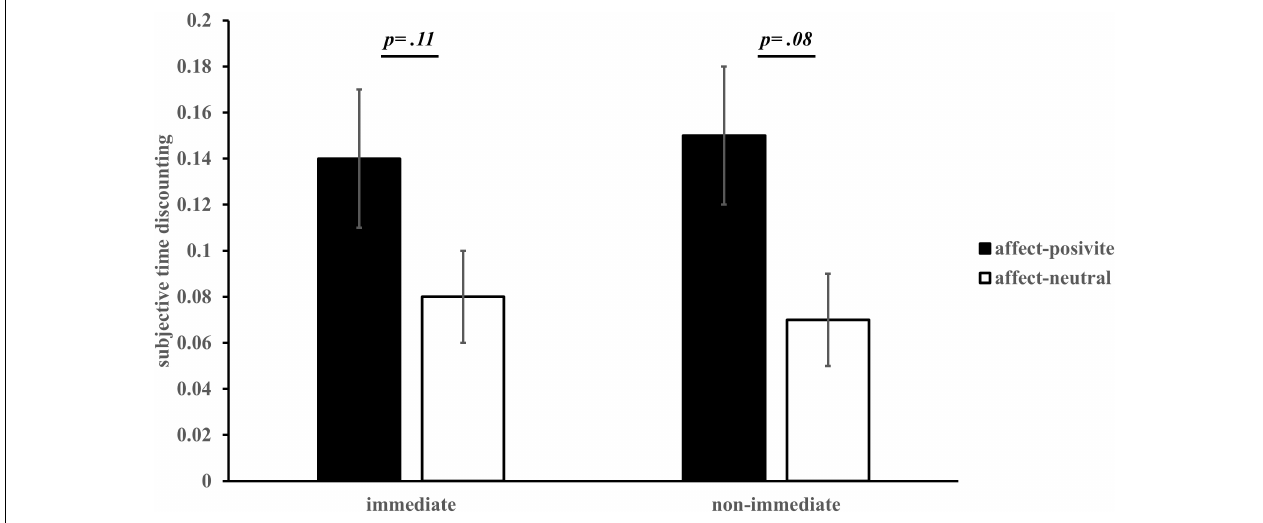
FIGURE 5 | Subjective time discount rate in different groups (M ± SE)